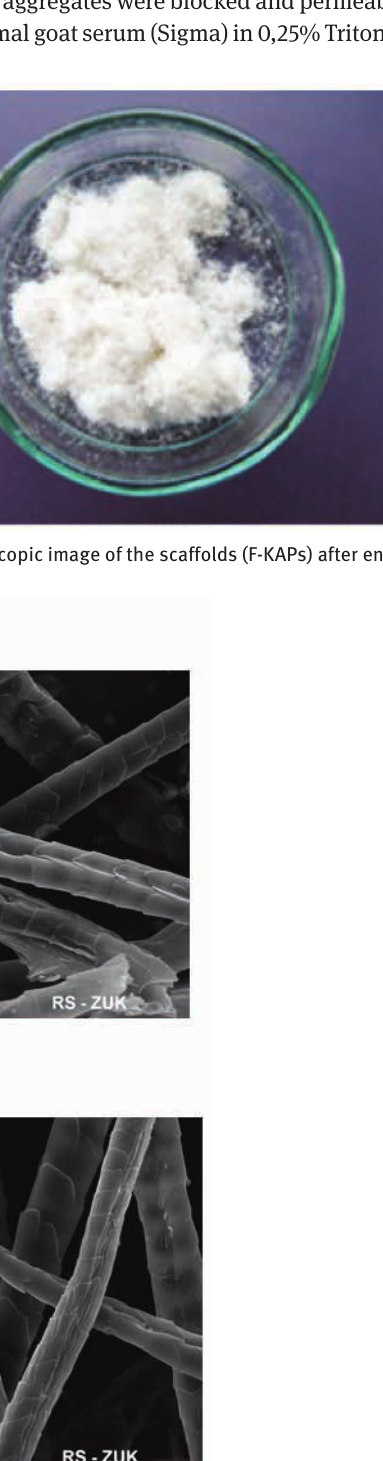
Figure 2: Scanning electron microscopic observation: (A) control – untreated fur fibers and fur fibers (F-KAPs) digested with (B) pepsin, (C) papain, (D) pancreatin.